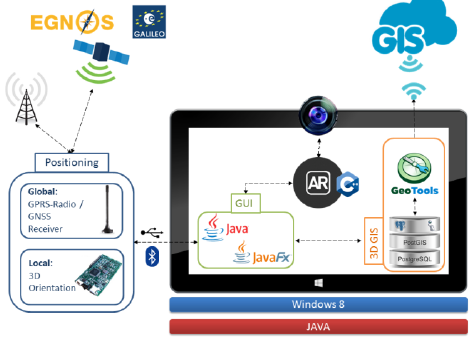
Figure 5: Physical view of LARA